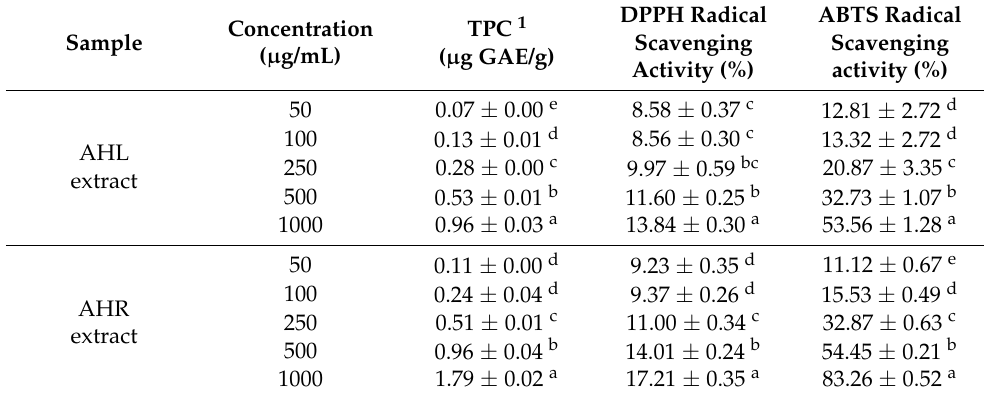
Table 1. Total phenolic contents and antioxidant activities of AHL and AHR